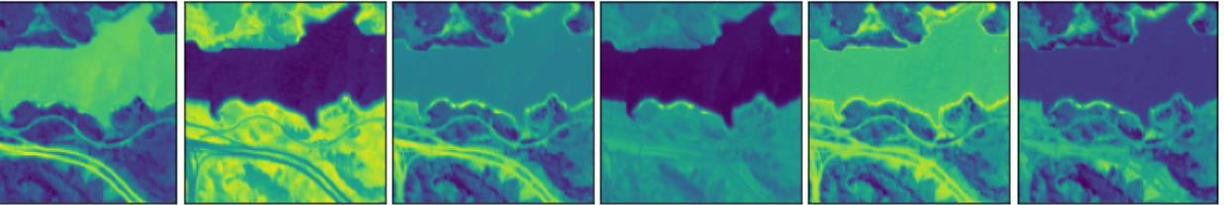
Figure 10. Abundance difference maps for Jasper Ridge. From left to right for different endmembers: road, soil, water and tree. From top to bottom for different methods.